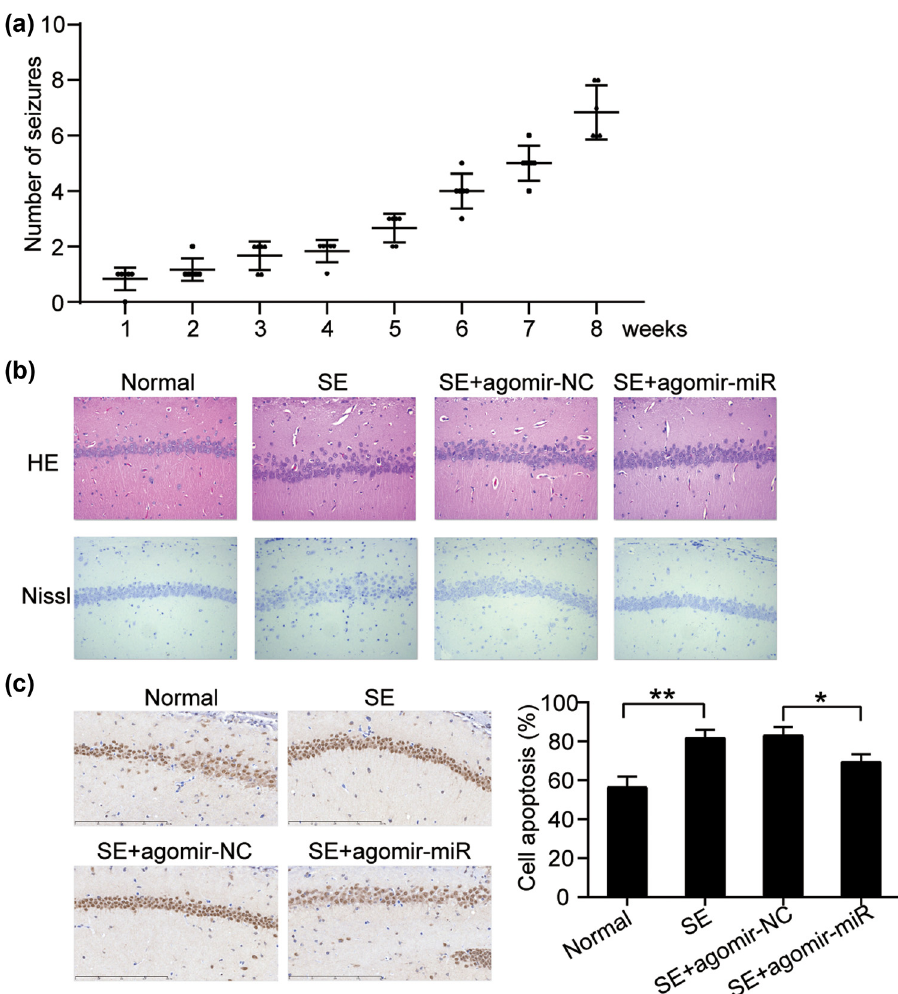
Figure 3: miR - 30b - 5p overexpression restored the pathological injury and cell apoptosis in hippocampal CA1 region. ( a ) Number of seizures of mice increases in the model group. ( b ) Pathological changes of hippocampal CA1 region were found in the model group after miR - 30b - 5p agomir or agomir negative control ( agomir NC ) was immediately injected via the tail vein. Hippocampal CA1 region using HE staining ( 400 ×) and Nissl ’ s staining. ( c ) TUNEL staining determining cell apoptosis rate in seizures. * P < 0.05, ** P < 0.001. NC, negative control; HE, hematoxylin and eosin; SE,